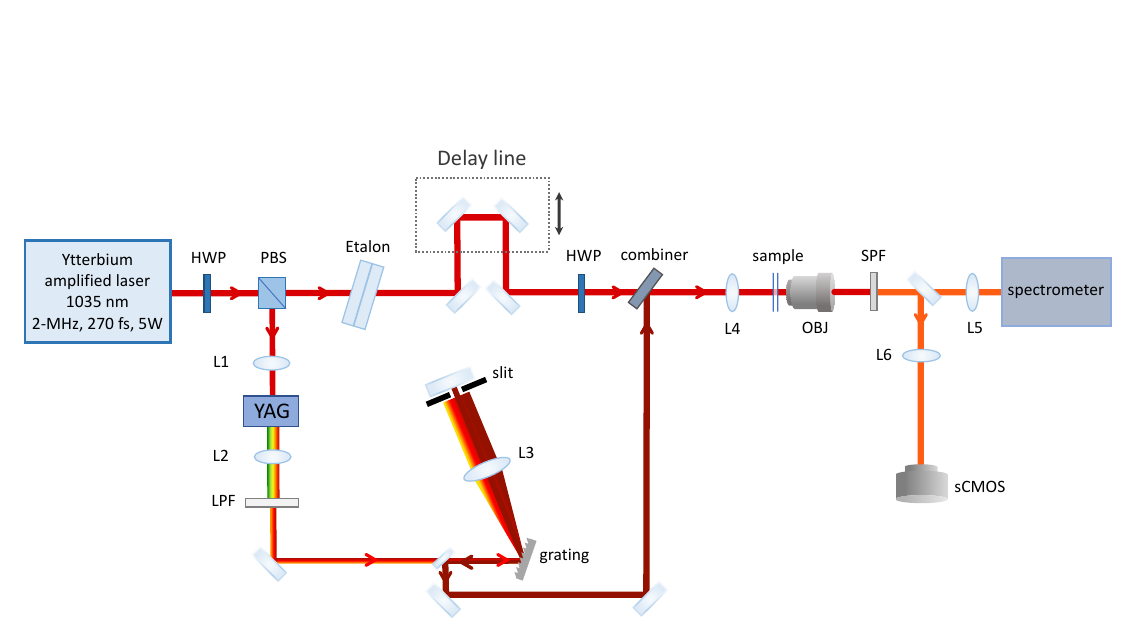
Figure 1. Scheme of the WF-CARS experimental setup. HWP: half-wave plate. PBS: Polarizing Beam Splitter. L1,L2,L3,L4,L5,L6: lenses. LPF: long-pass filter. OBJ: collection objective. SPF: short pass filter.